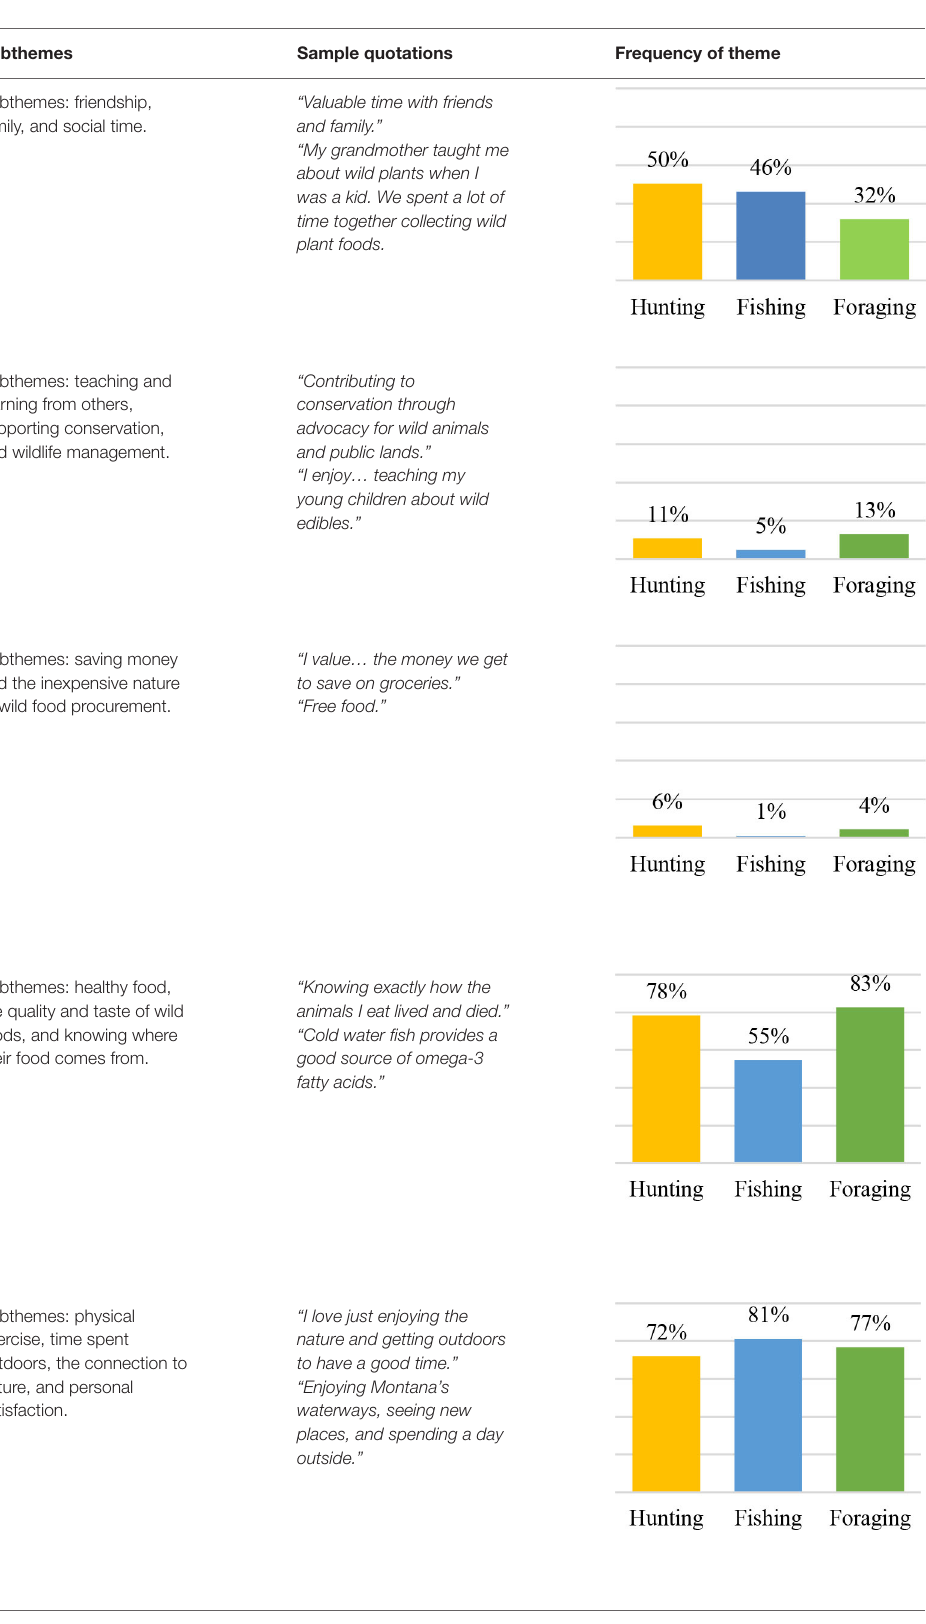
TABLE 1 | Values related to hunting, fishing, and foraging coded into the most prevalent themes: food and/or health, recreation and/or self-fulfillment, companionship, conservation and education, and economic. Wild food